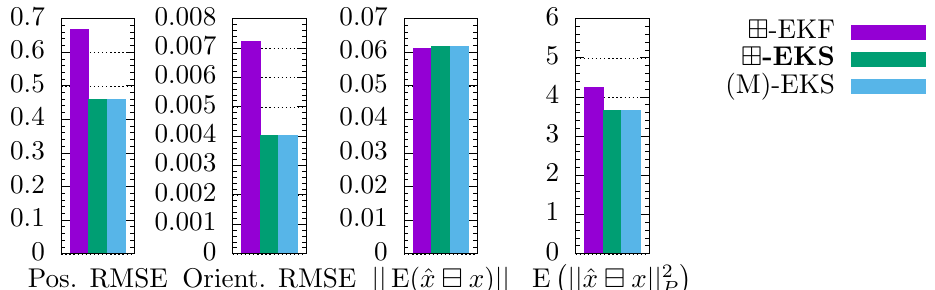
Figure 7. RMSE and consistency comparison of single-model estimators with additional noise on the